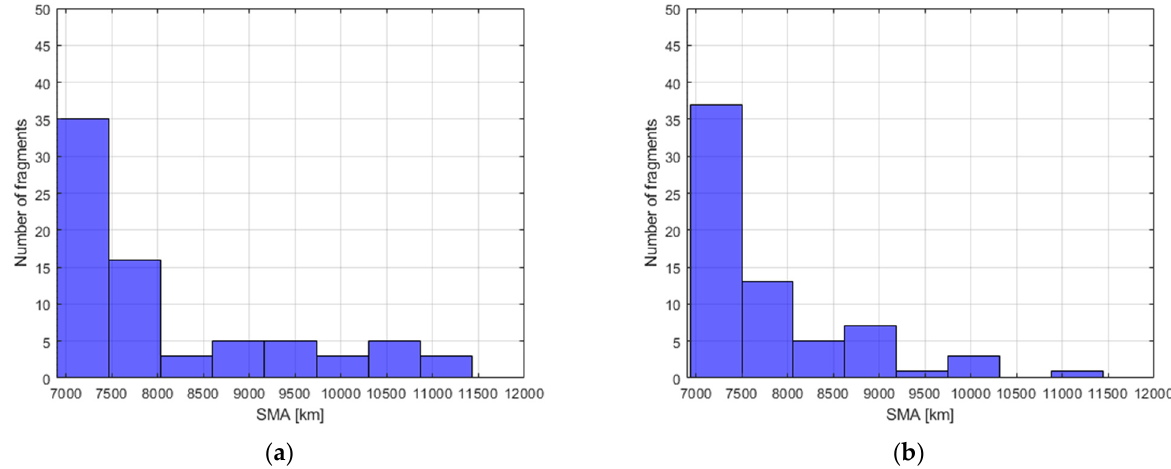
Figure 15. Histograms of reference ( a ) and estimated ( b ) fragments in range [6900, 12,000] km of semimajor axis for second test case.